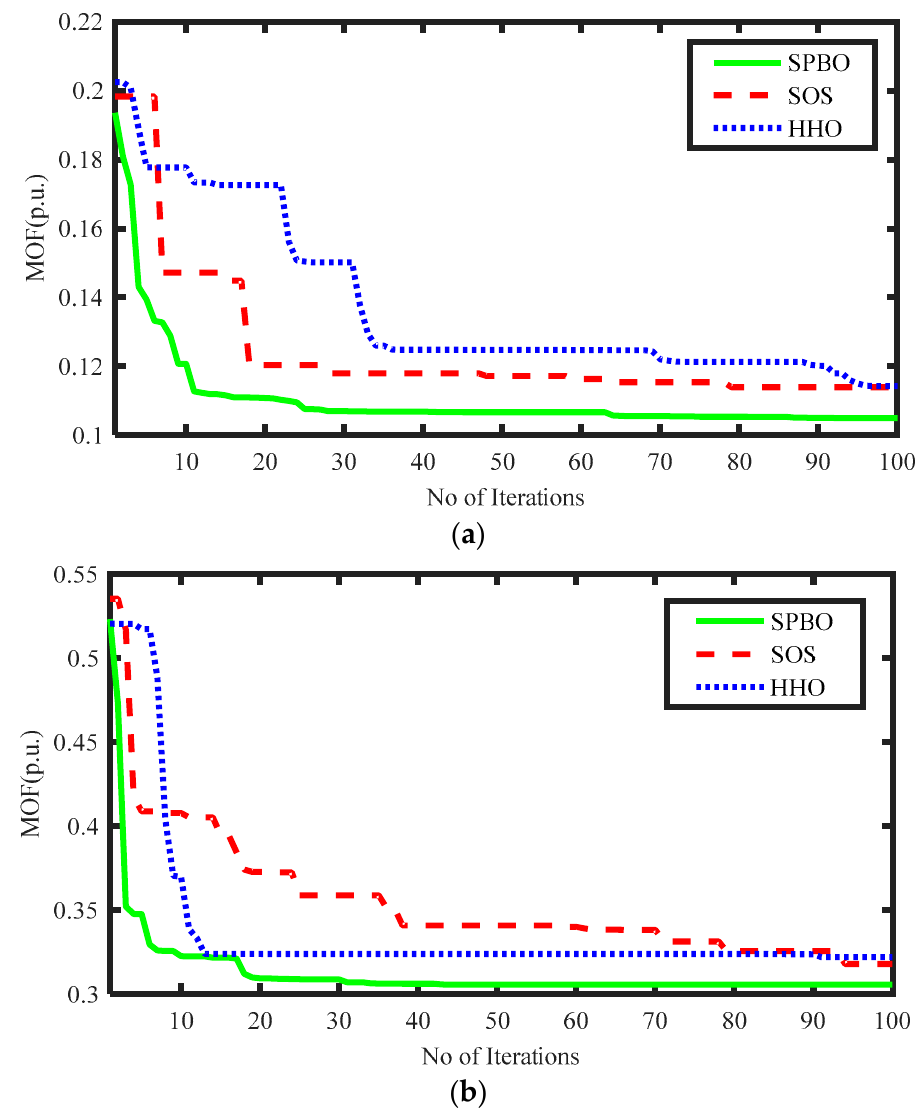
Figure 7. CC of optimization algorithms for case-6. ( a ) 33-bus test system; ( b ) 118-bus test system. Table 13. Comparison of results for simultaneous DS and 2 PV-DG and 1 GT-DG allocation (case-7) for 33-bus test